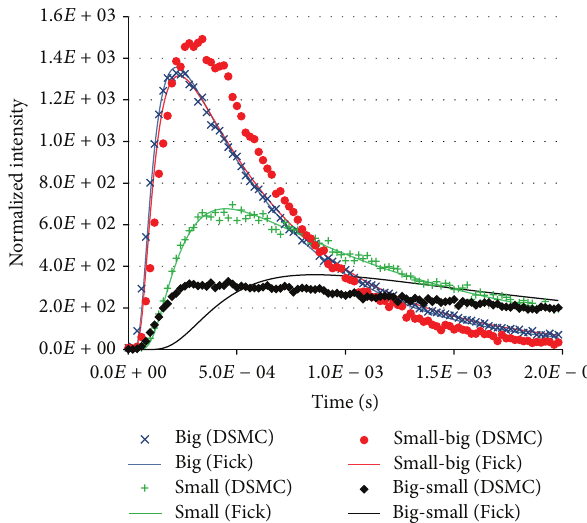
Figure 4: Pulse responses of pore combinations and individual pores.